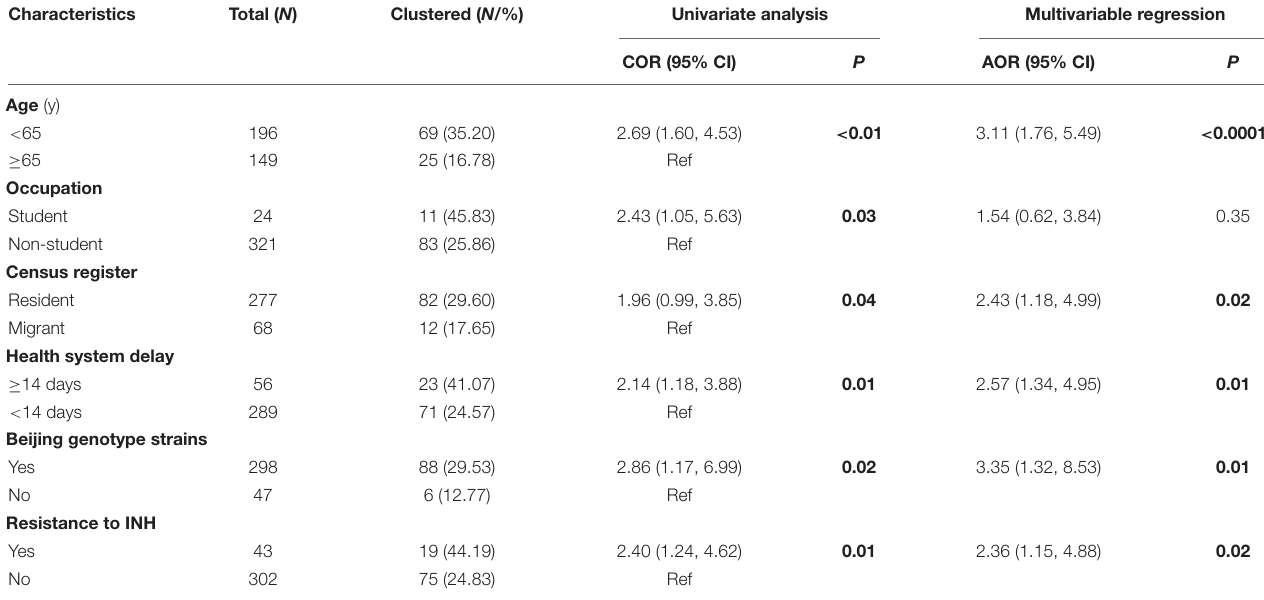
TABLE 3 | Univariate and multivariable regression analysis on the risk factors of genomic clustering.